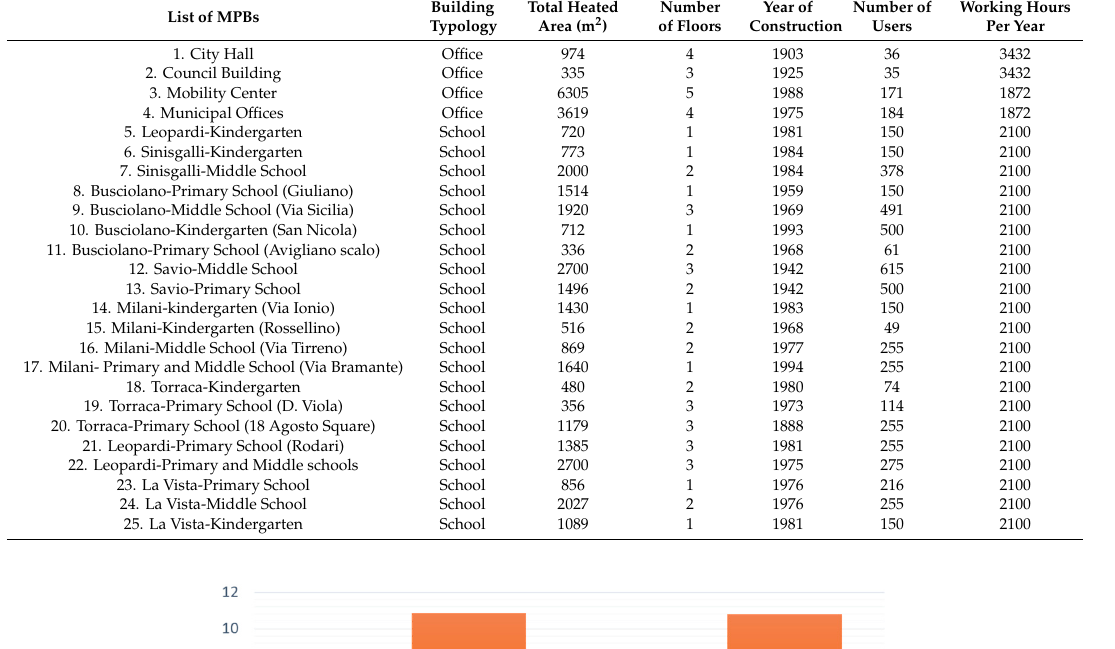
Table 1. Main structural and energy characteristics of the 25 sample buildings selected for the Municipality of Potenza.